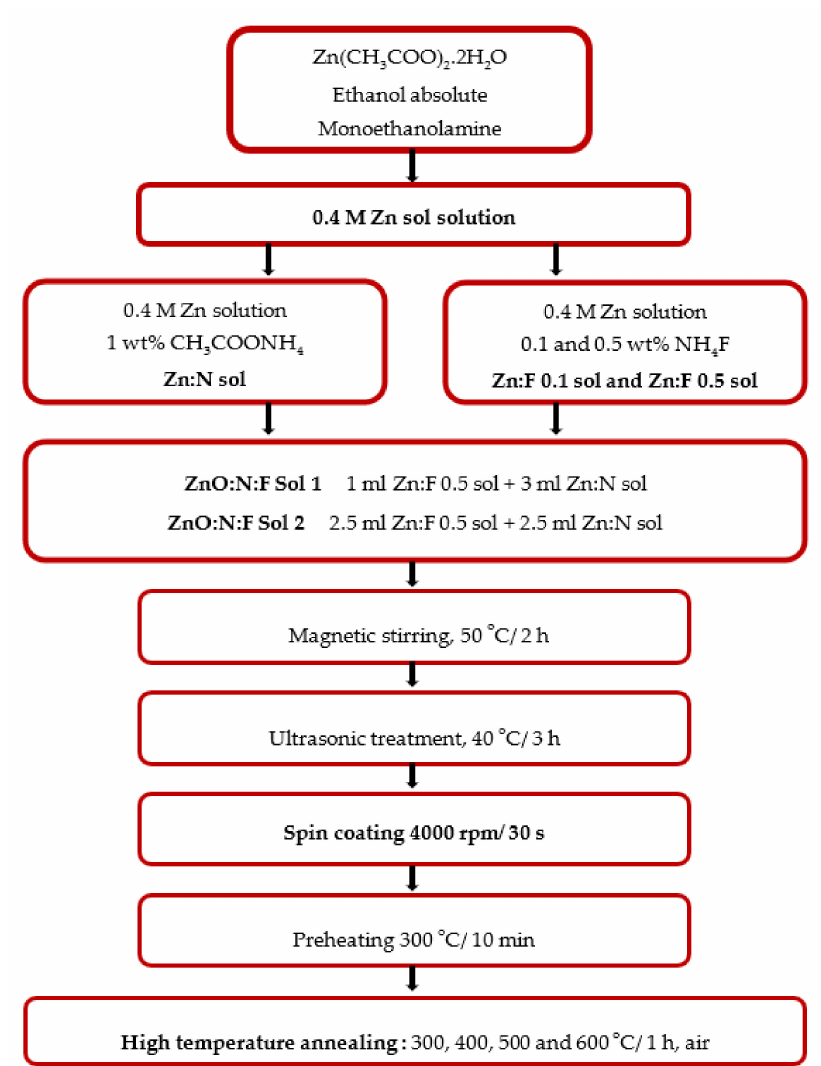
Figure 1. Schema of sol solution synthesis and thin film deposition.